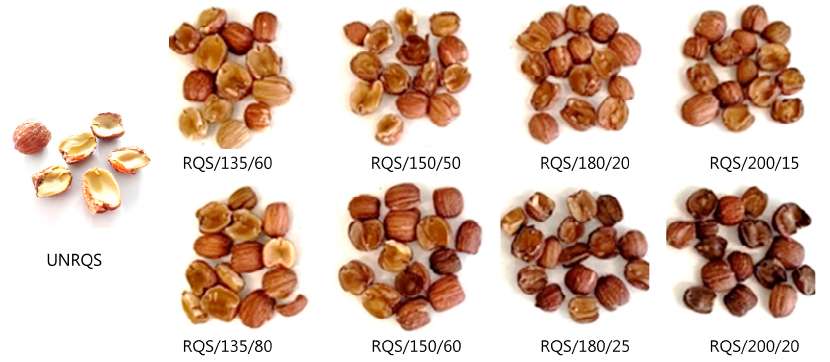
Figure 4. Representative images of unroasted and roasted Q. rubra (syn. Q. borealis F. Michx) seeds; UNRQS, the unroasted seeds; RQS/135/60, seeds roasted at 135 °C/60 min, RQS/135/80, seeds roasted at 135 °C/80 min; RQS/150/50, seeds roasted at 150 °C/50 min; RQS/150/60, seeds roasted at 150 °C/60 min; RQS/180/20, seeds roasted at 180 °C/20 min; RQS/180/25, seeds roasted at 180 °C/25 min; RQS/200/15, seeds roasted at 200 °C/15 min; RQS/200/20, seeds roasted at 200 °C/20 min.